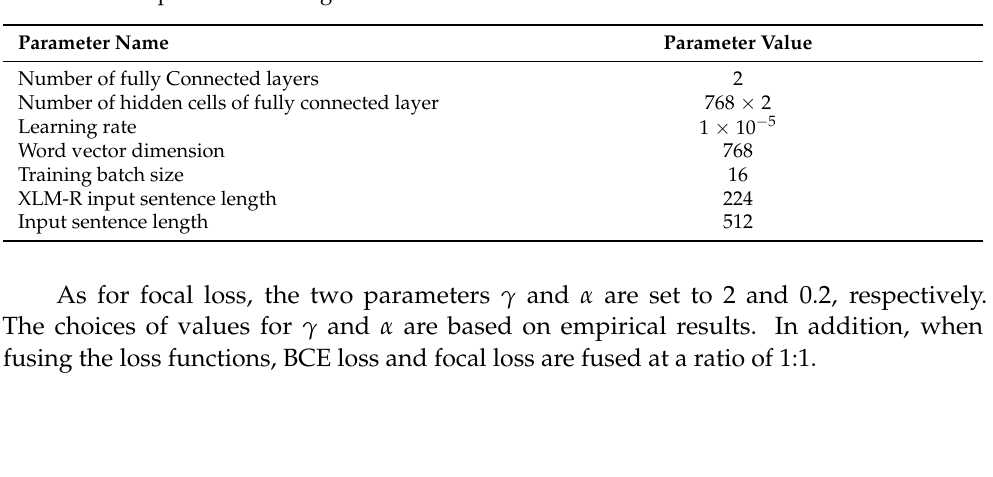
Table 3. Model parameter